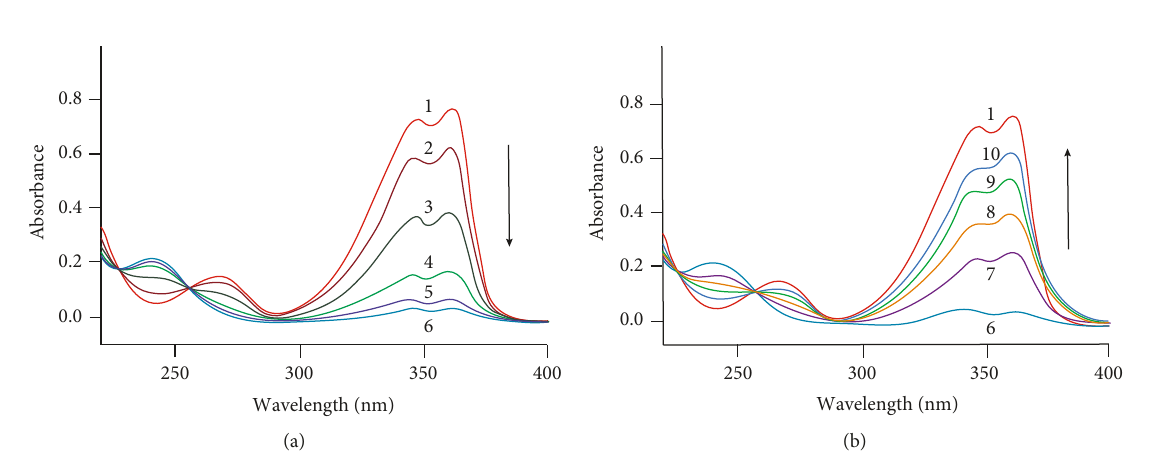
Figure 2: Electronic absorption spectra of 1 in acetonitrile ( 3 0 · 10 − 5 M ). (a) Before ( 1 ) and after 10 s ( 2 ), 20s ( 3 ), 30s ( 4 ), 40 s ( 5 ), 50s ( 6 ), and 60s ( 7 ) of irradiation with light of 365nm. (b) Dark thermal inverse reaction: immediately after the end of irradiation ( 6 ), after 9s ( 7 ), 17 s ( 8 ), 29s ( 9 ), and 45s ( 10 ).